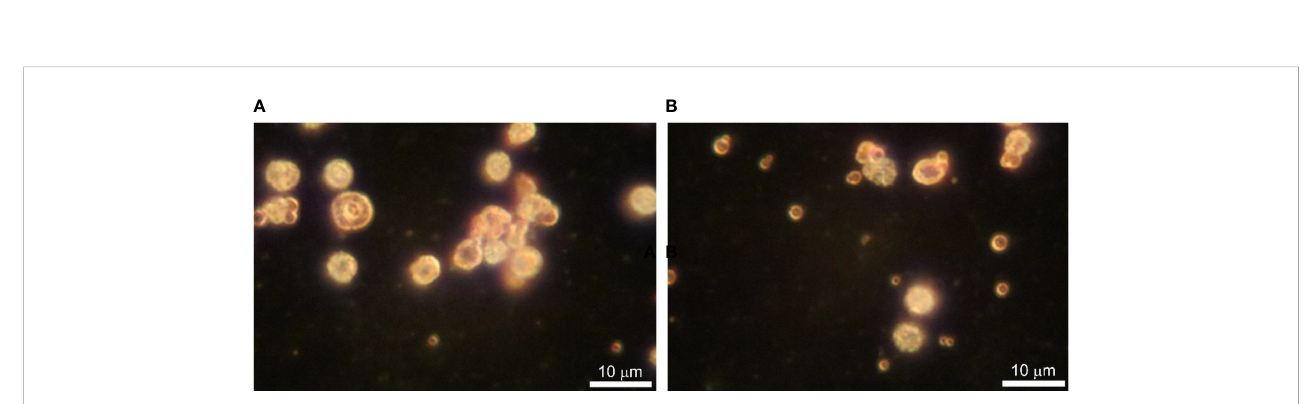
FIGURE 3 (A, B) Dark- fi eld microscopy of in vitro cultured lysed blood in BHI broth supplemented with vitamin K at 43 ○ C for 24 h. Bar 10 µm.